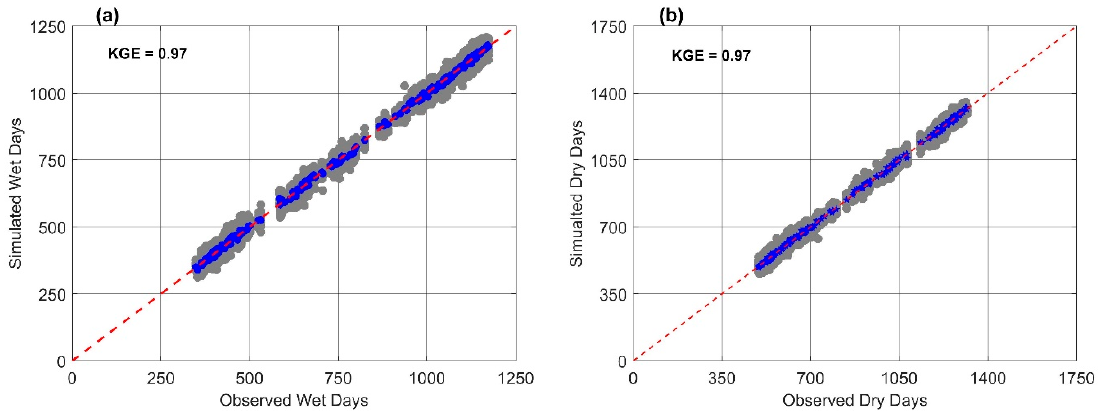
Figure 4. Comparison of the daily precipitation states between the observations and simulations for all months and grid-cells.